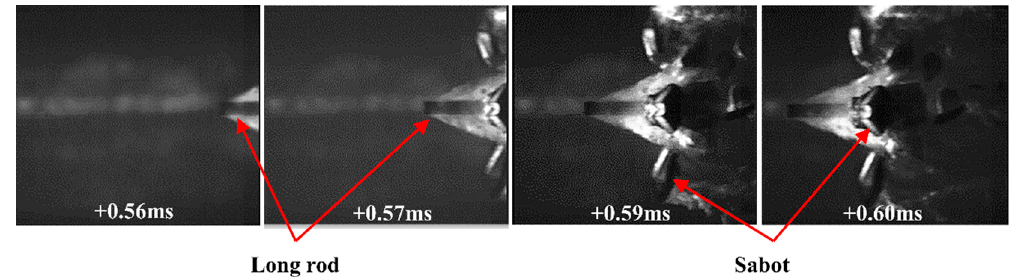
Figure 3. Typical long-rod projectile photographs from the high-speed camera.